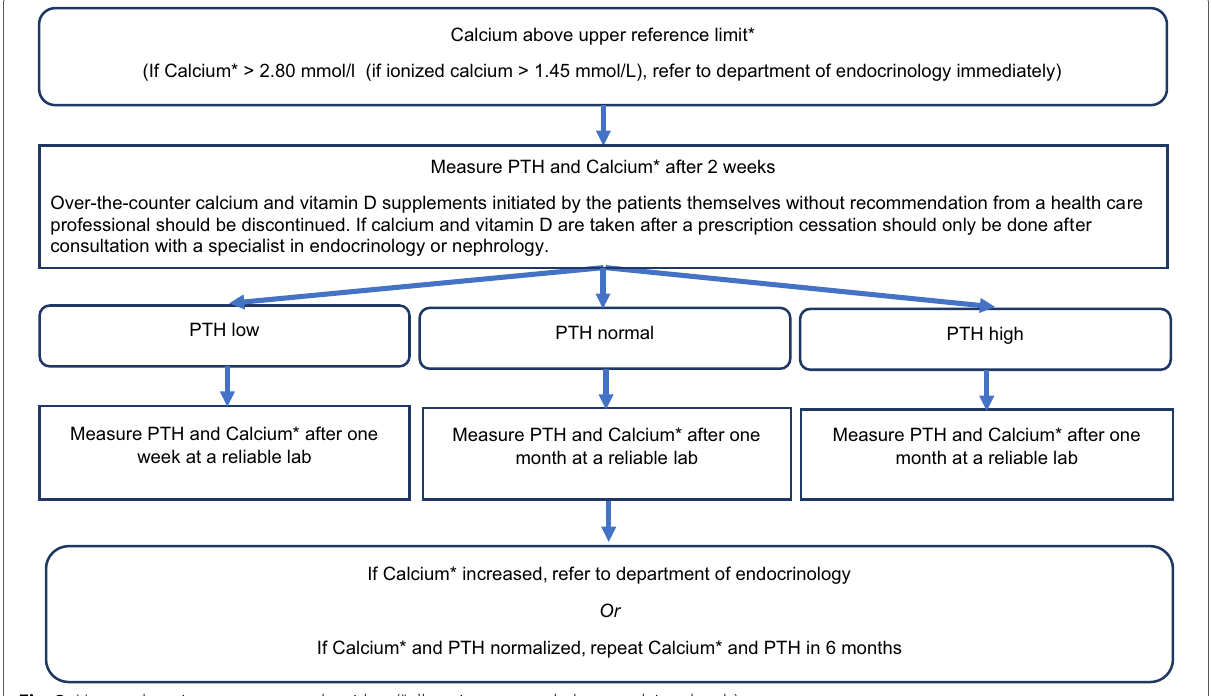
Fig. 2 Hypercalcemia management algorithm (*albumin‑corrected plasma calcium